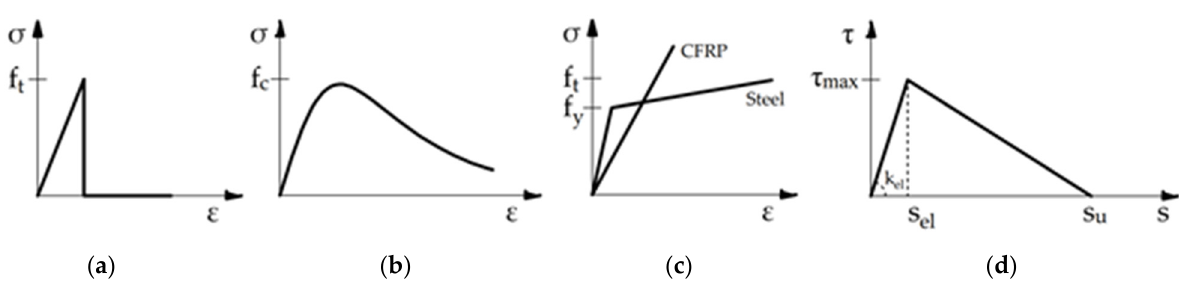
Figure 4. Constitutive laws for materials and bond behavior: ( a ) Tensile stress-strain relationship for concrete; ( b ) stress- strain relationship for concrete in compression; ( c ) Tensile stress-strain relationships for CFRP and steel plates; ( d ) Bilinear interfacial bond law.